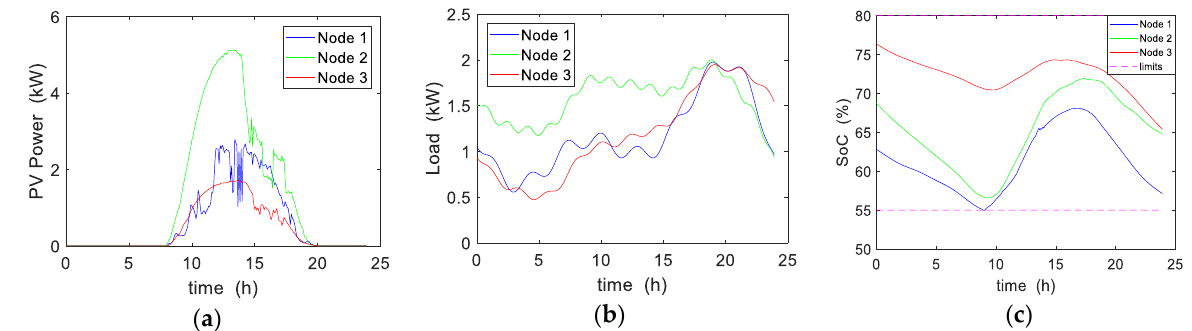
Figure 11. Renewable power and loads simulating unpredicted conditions: ( a ) PV power production; ( b ) Local load demand; ( c ) Battery SOC evolution at each node.